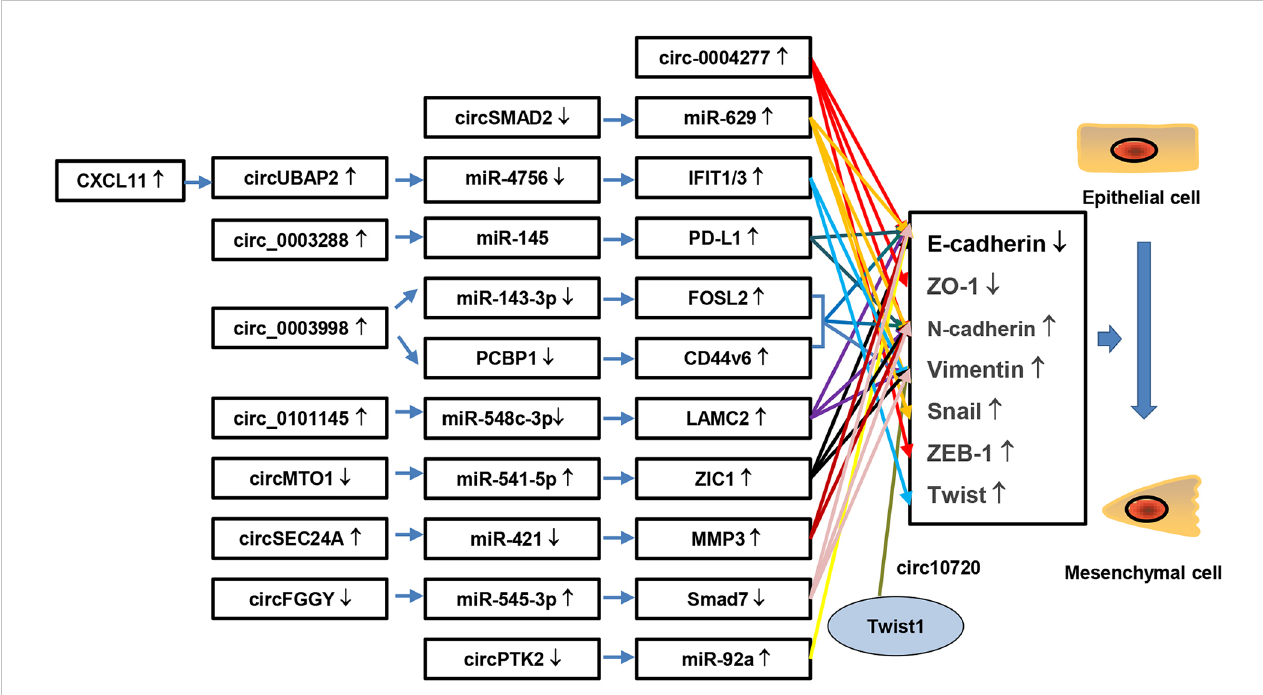
FIGURE 2 CircRNAs participate in EMT progression in HCC. CircRNAs participate in EMT by decreasing expression of epithelial phenotype markers, such as E- cadherin and ZO-1, while increasing that of mesenchymal phenotypic markers, such as N-cadherin and